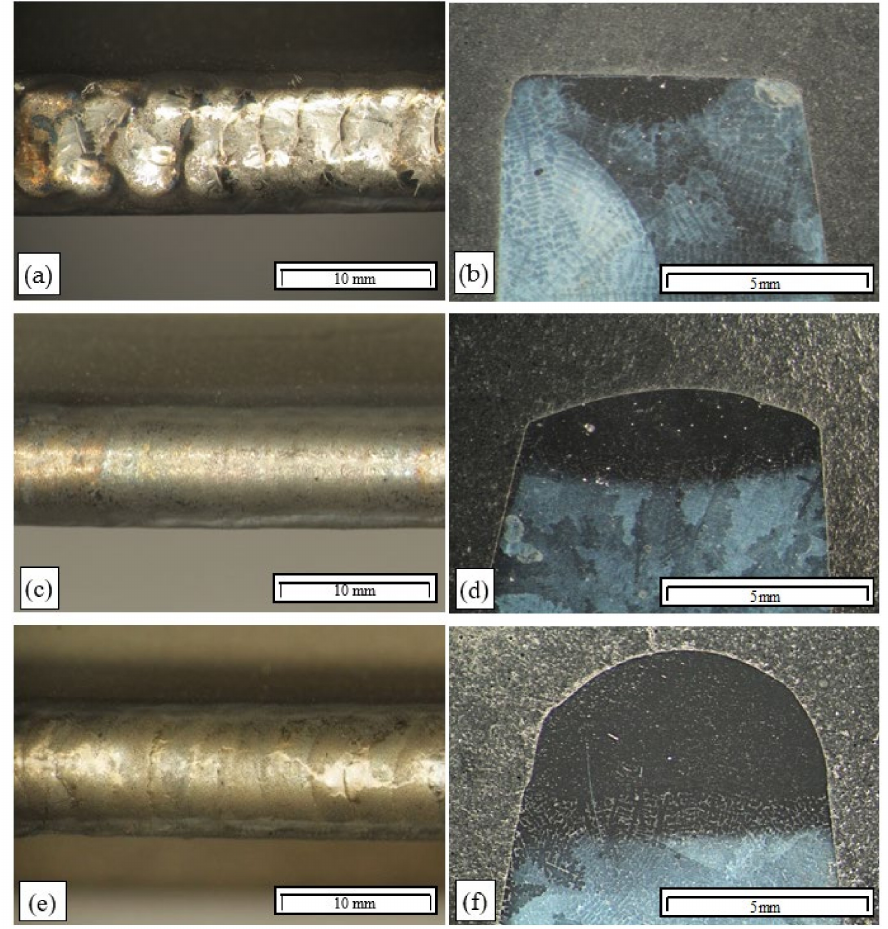
Figure 9. Surfaces and macrostructures of a remelted area and two padding welds made by TIG: ( a , b ) remelting of the base material with no filler, arc linear energy: 0.18 kJ/mm; ( c , d ) padding weld, arc linear energy: 0.34 kJ/mm; ( e , f ) padding weld made with Thermanit 625 wire, arc linear energy: 0.35 kJ/mm.